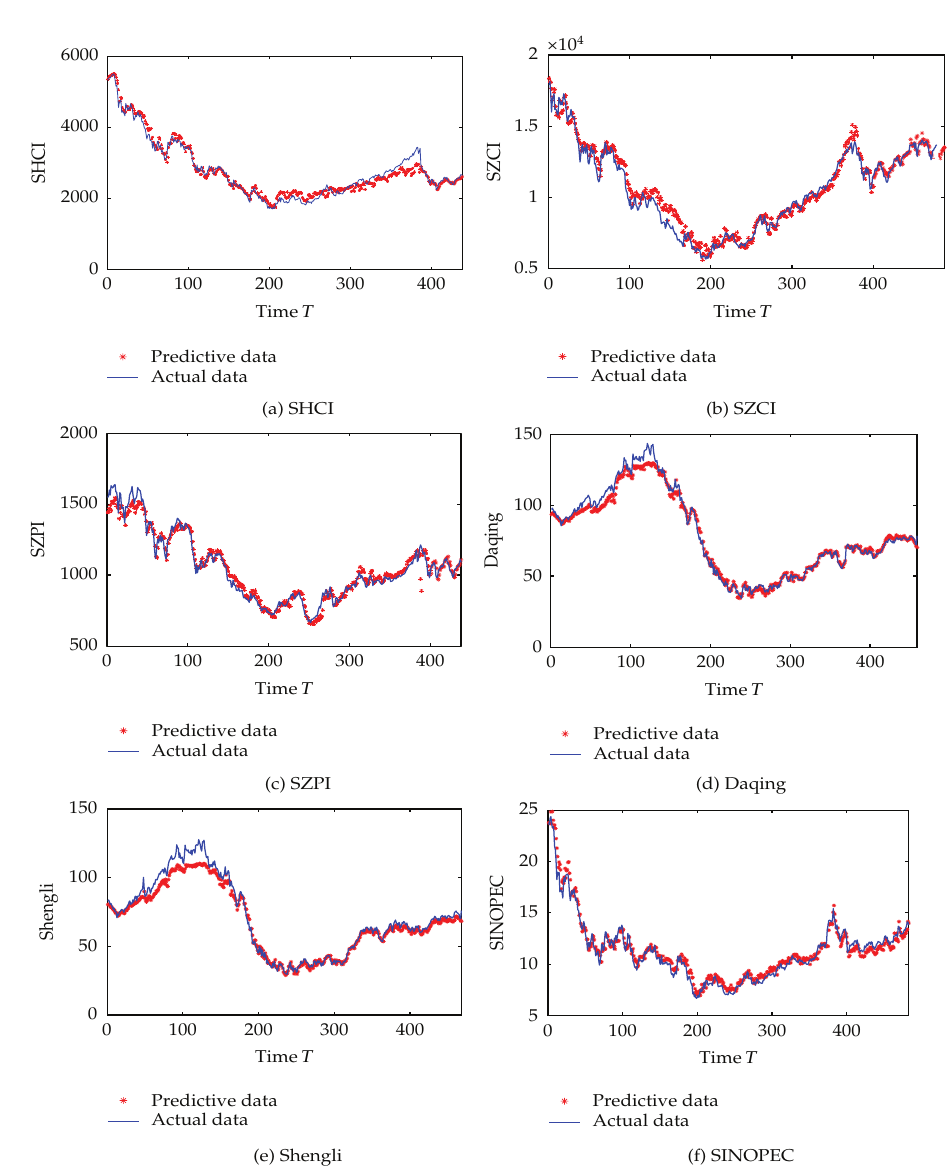
Figure 4: Comparisons of the predictive data and the actual